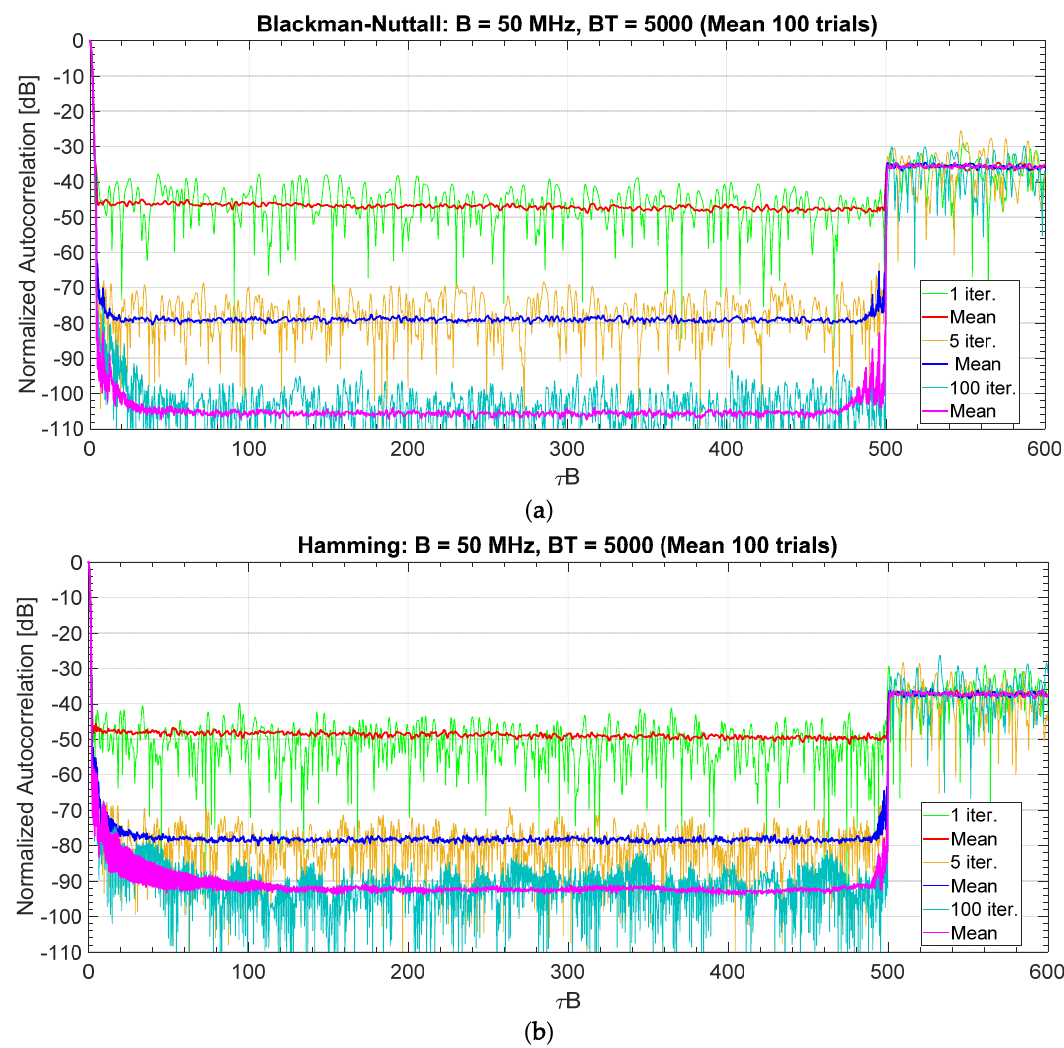
Figure 18. Normalized ACF when the FMeth is used to suppress a sidelobes region (varying the number of iterations: n iter = 1, 5, 100) for a single realization and averaging 100 trials. The PAPR assumes its “naturally” value (10–12). The suppression zone is the 20% of the total. ( a ) Blackman-Nuttall spectrum, and ( b ) Hamming spectrum.